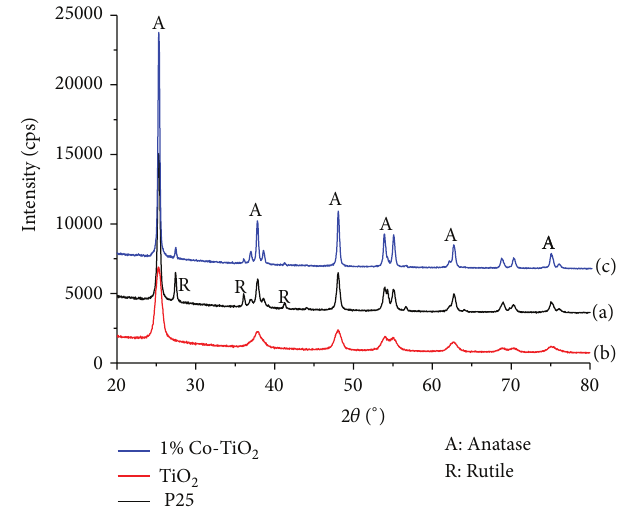
Figure 2: XRD spectra of photocatalysts: (a) P25, (b) TiO 2 , and (c) 1% Co-TiO 2